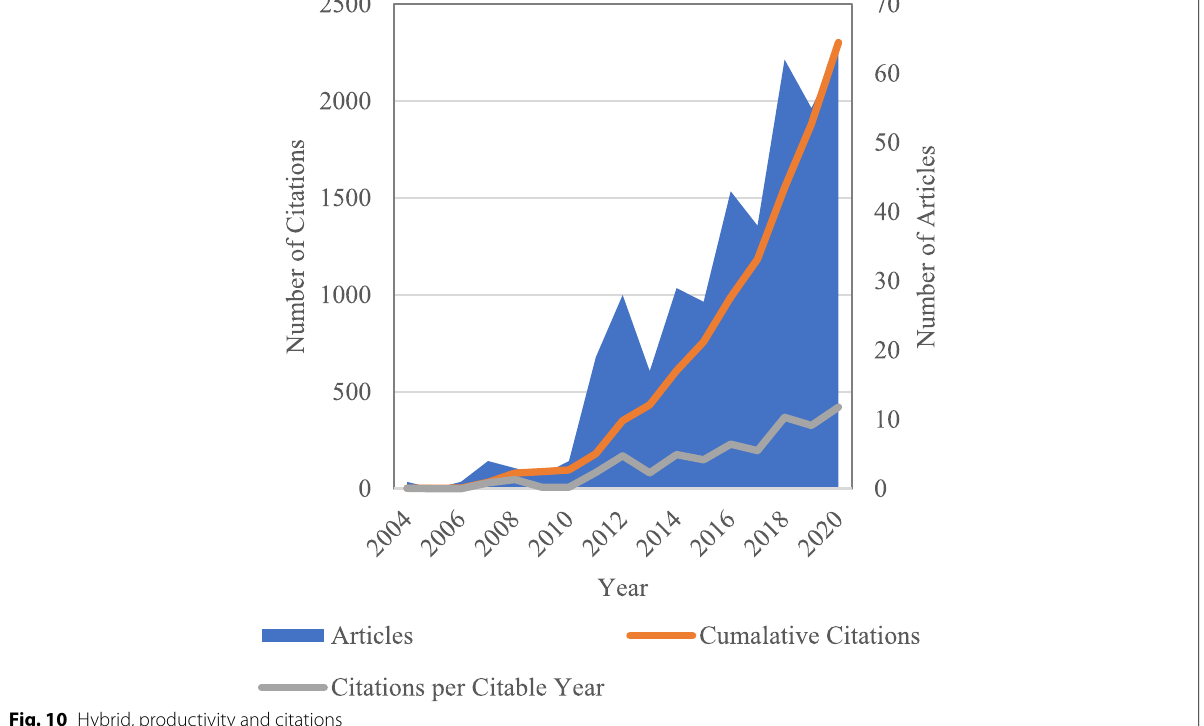
Fig. 10 Hybrid, productivity and citations